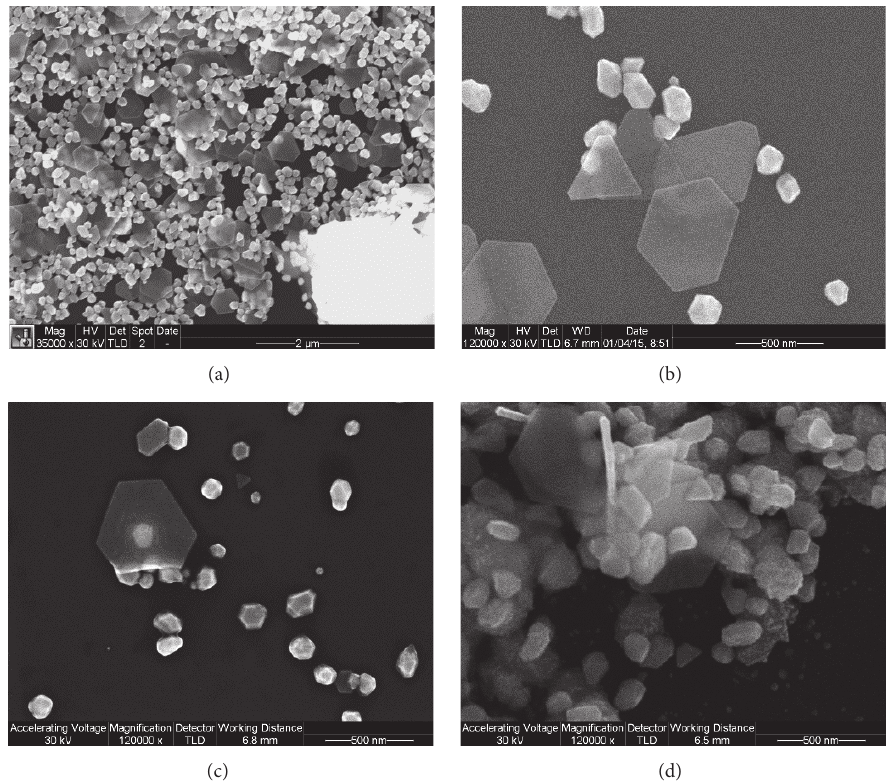
Figure 1: SEM images showing results from gold nanoparticle synthesis with variances in manner and order of addition. (a) Simple addition of HAuCl 4 to solution of 5-HIAA. (b) Dropwise addition of HAuCl 4 . (c) Dropwise addition of 5-HIAA to solution of HAuCl 4 . (d) Simple addition of 5-HIAA to solution of HAuCl 4 .